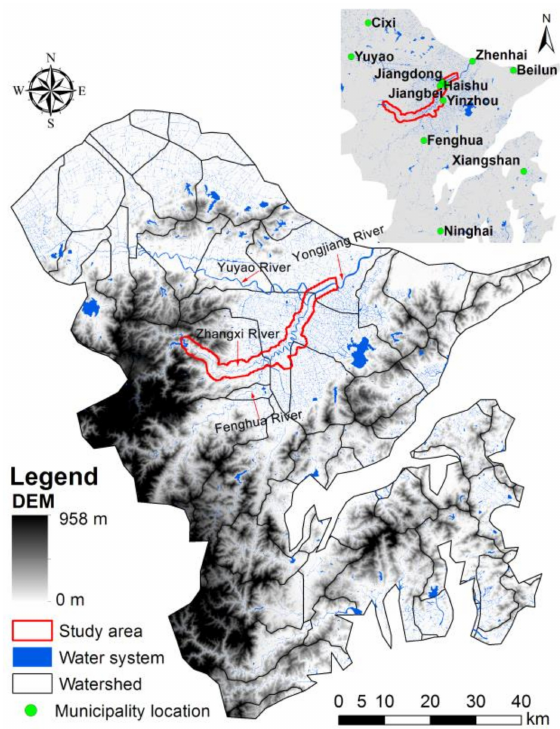
Figure 1. Locations of the study area, the water system, municipal governments of districts in Ningbo